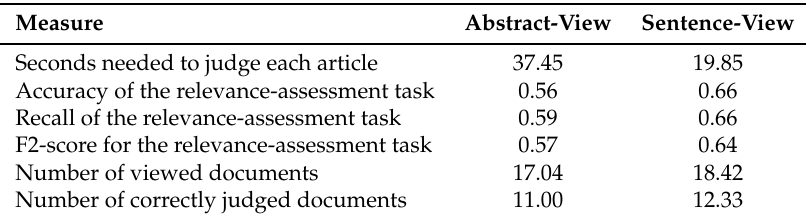
Table 3. Results of the relevance assessment